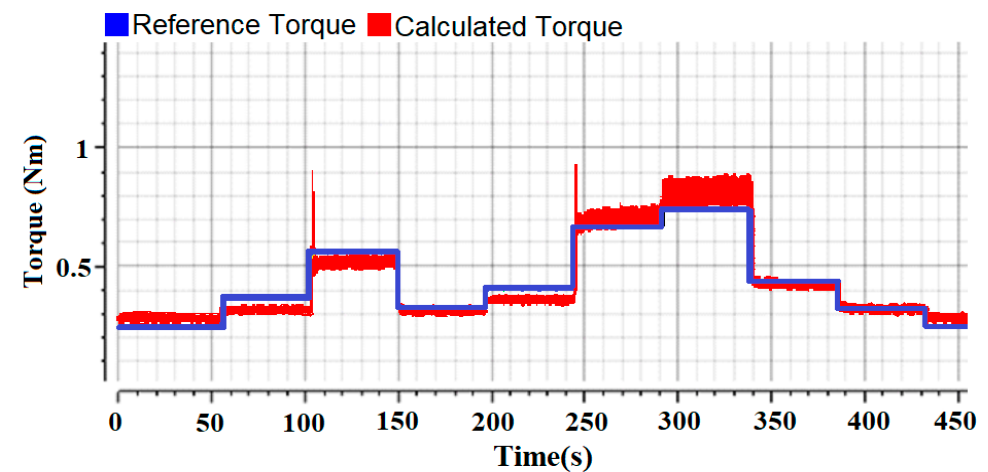
Figure 25. Reference and load torque (experimental results).